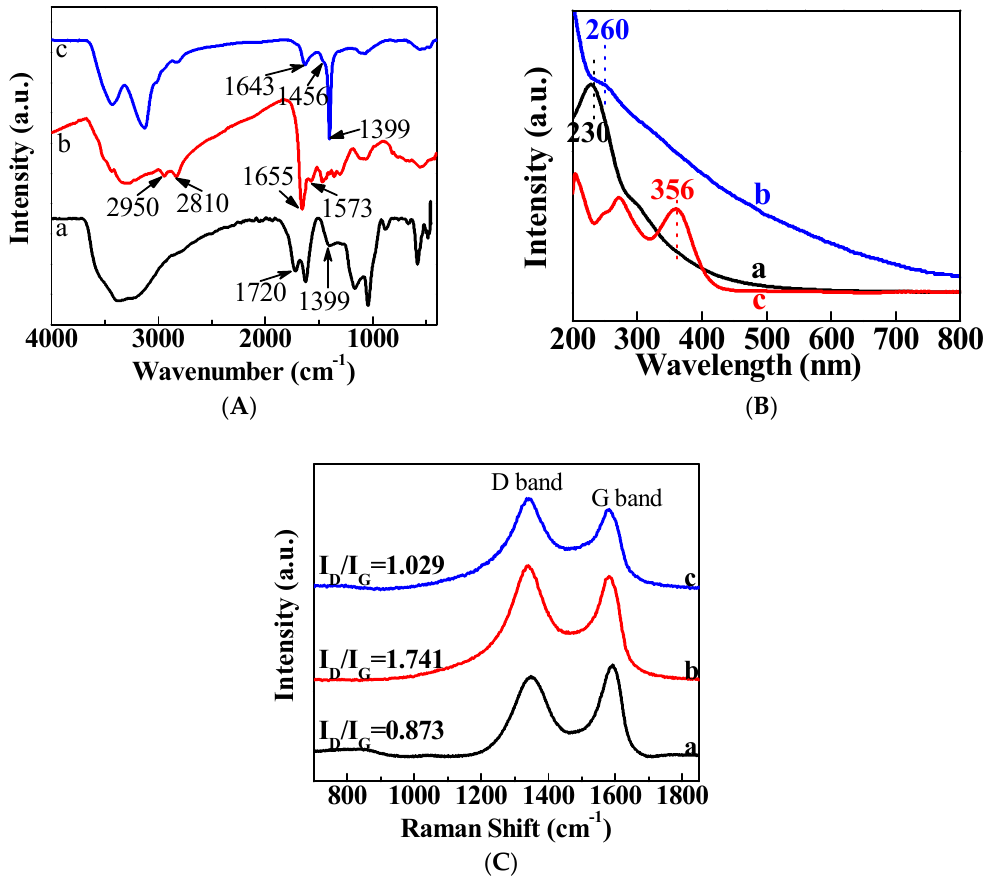
Figure 2. FTIR spectra ( A ), UV–vis absorption spectra ( B ), and Raman spectra ( C ) of GO nanosheets ( a ), PG nanosheets ( b ), and TC/PG ( c ) nanocomposites.